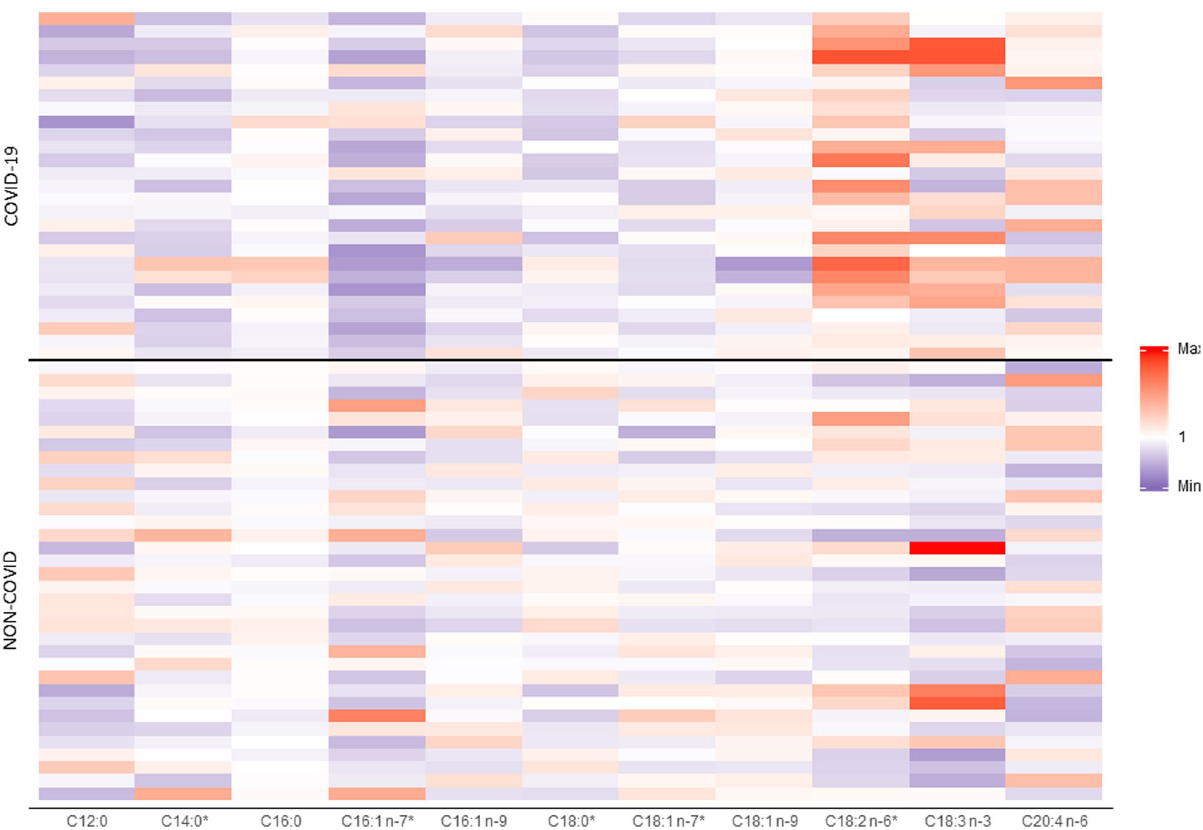
Figure 3. Heatmap of non-esterified fatty acid (NEFA) representation (as percentage normalized to the mean percentage in non-COVID-19 patients) according to COVID-19 status. Plasma concentration of NEFAs was measured in 34 non-COVID-19 and 27 COVID-19 patients with severe pneumonia. Rows represent patients. Colours represent the ratio between the percentage of NEFAs in the patient and the mean percentage of NEFAs in non-COVID-19 patients. In COVID-19 patients, linoleic acid appeared in red, reflecting a higher representation. *significant between-group differences ( p <